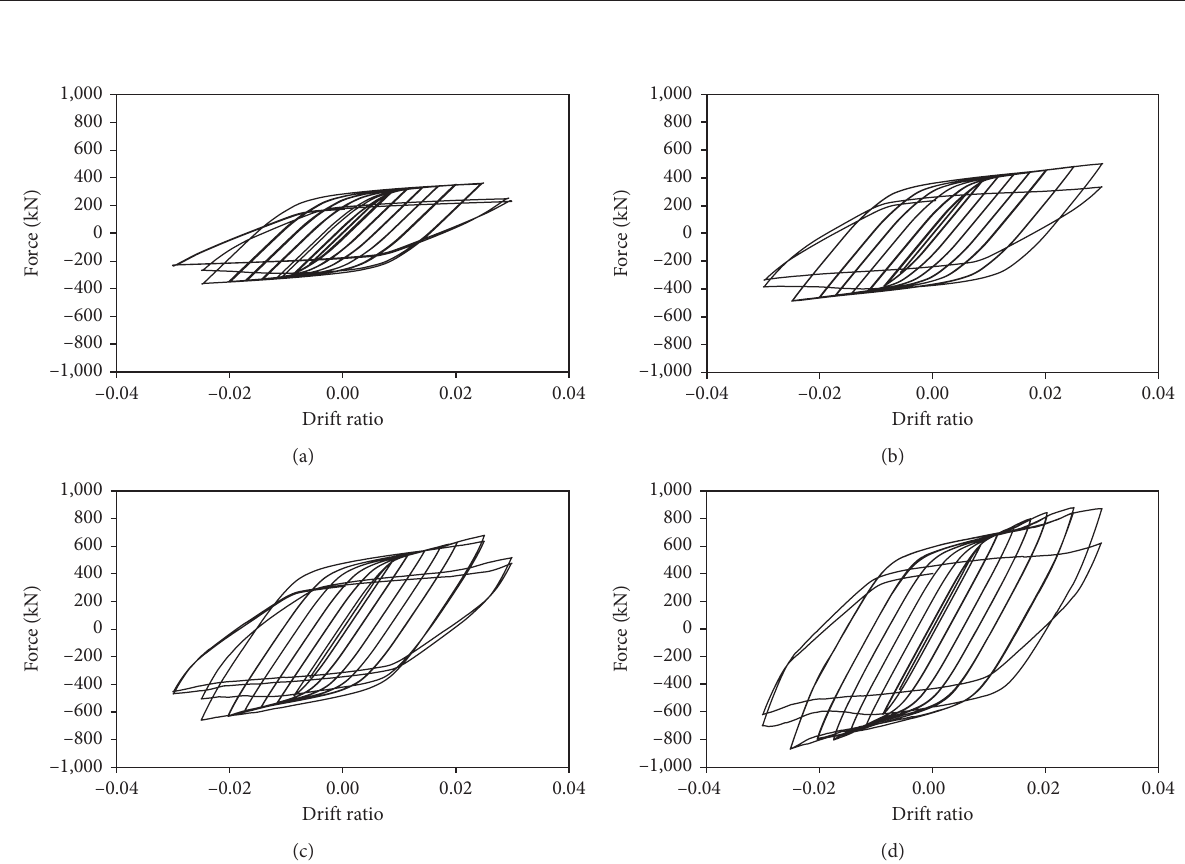
Figure 16: Hysteresis curves of beam-only-connected H-CSPSWs at different panel aspect ratios. (a) Ar � 1.00. (b) Ar � 1.67. (c) Ar � 2.33. (d) Ar �